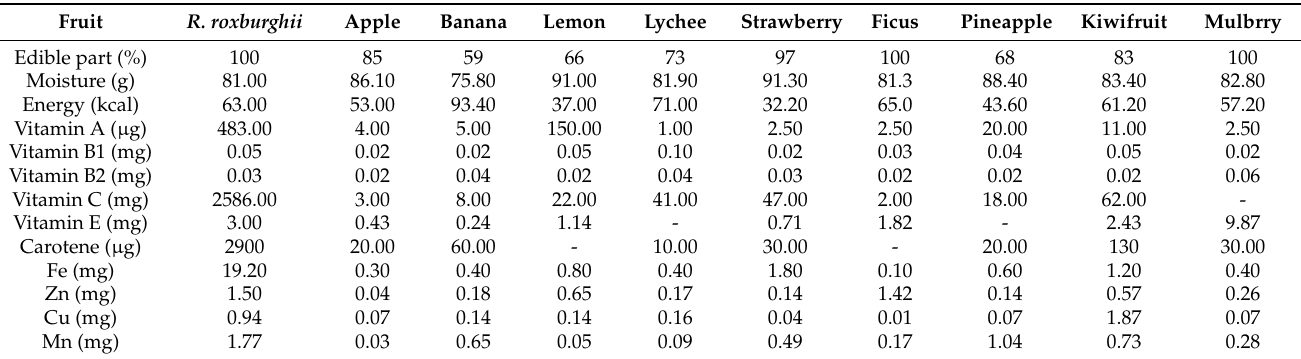
Table 2. Comparation of important vitamin and mineral contents of R. roxburghii fresh fruits and other common fresh fruits (calculated per 100 g edible part)